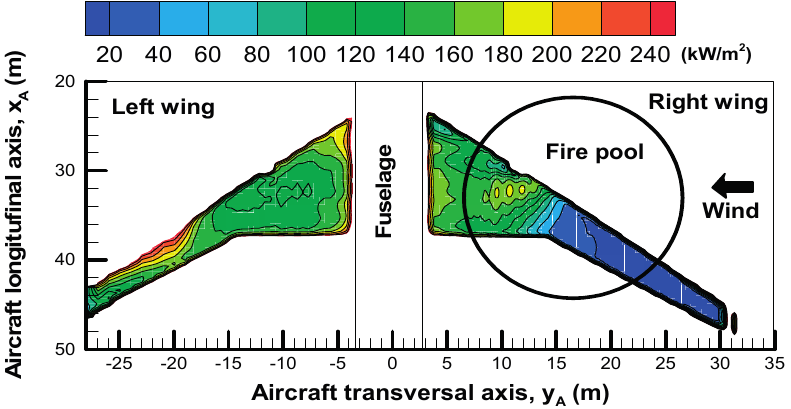
Figure 17. Iso-contour of the incident heat flux on the wings’